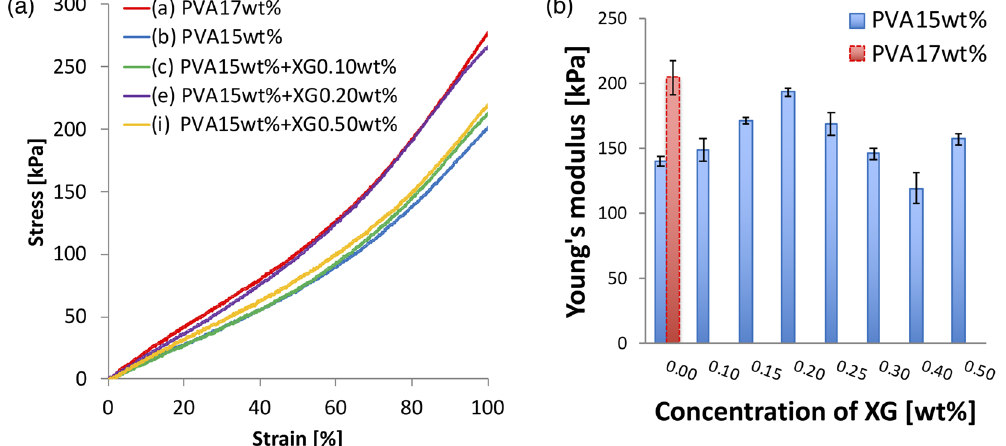
Figure 2. The results of the tensile test. ( a ) Stress–strain curves in tensile tests of PVA-H specimens. The Young’s modulus in each specimen is defined at 50% strain. These results show the third time measurements. ( b ) Relationship between Young’s modulus in 17 and 15 wt% PVA-H specimens and XG concentration. (n = 3, mean ± SD).